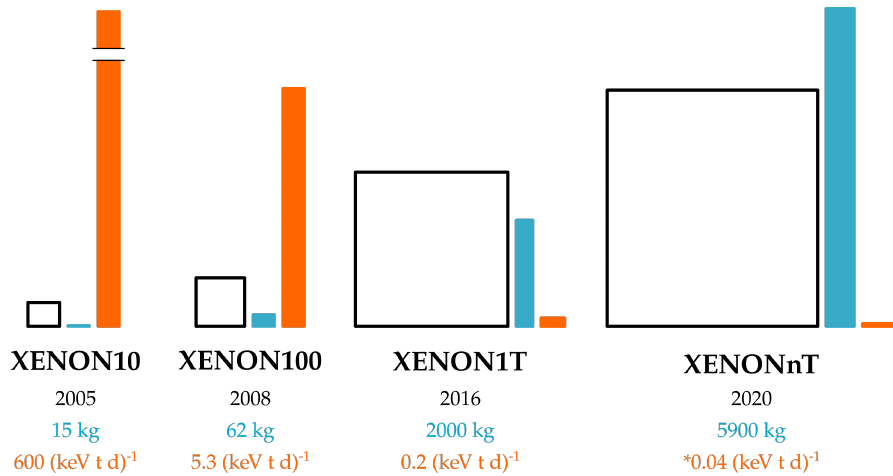
Figure 4. The detectors of the XENON dark matter search program. The dimensions of the cylindrical TPCs (diameter and height) are compared by the empty boxes with black contour (the relative scale and shape differences among the detectors are faithfully preserved): 20 × 15 cm (XENON10), 30.6 × 30.5 cm (XENON100), 96 × 97 cm (XENON1T), 132.8 × 148.5 cm (XENONnT). The year of construction is reported in black. The cyan bars and text show the active LXe mass (contained inside the TPC). The total amount of LXe used inside the cryostat is: 25 kg (XENON10), 161 kg (XENON100), 3200 kg (XENON1T), 8000 kg (XENONnT). In orange, the level of low-energy ER background ( (cid:46) 20 keV) is shown. The XENONnT rate (marked with *) is the experiment’s goal according to the expected performance and